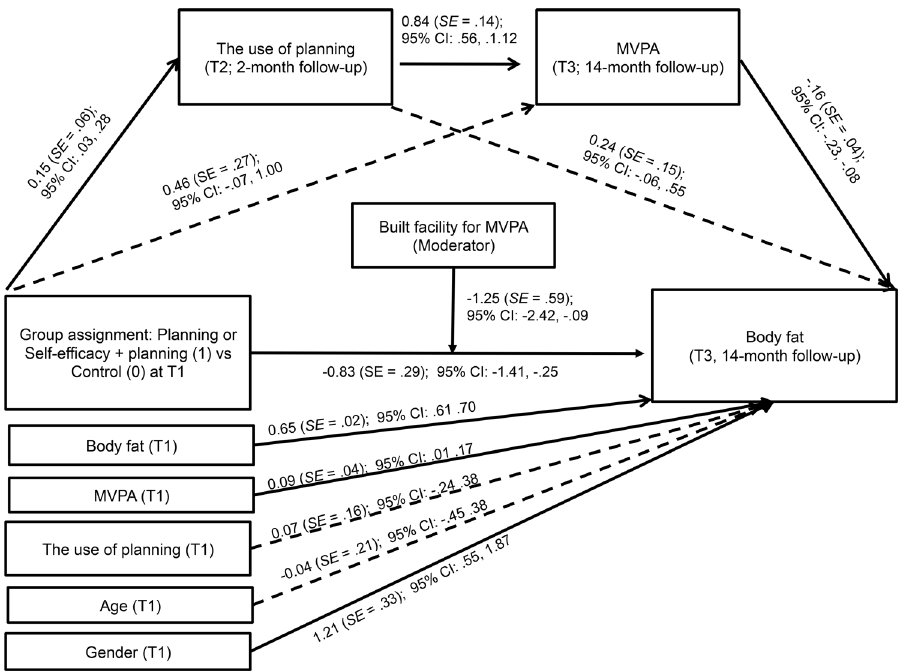
Fig 3. Effects of the group assignment (planning or self-efficacy + planning versus control) on body fat (14-month follow-up) mediated by planning and moderate-to-vigorous physical activity. Solid lines represent significant associations. MVPA – moderate-to-vigorous physical